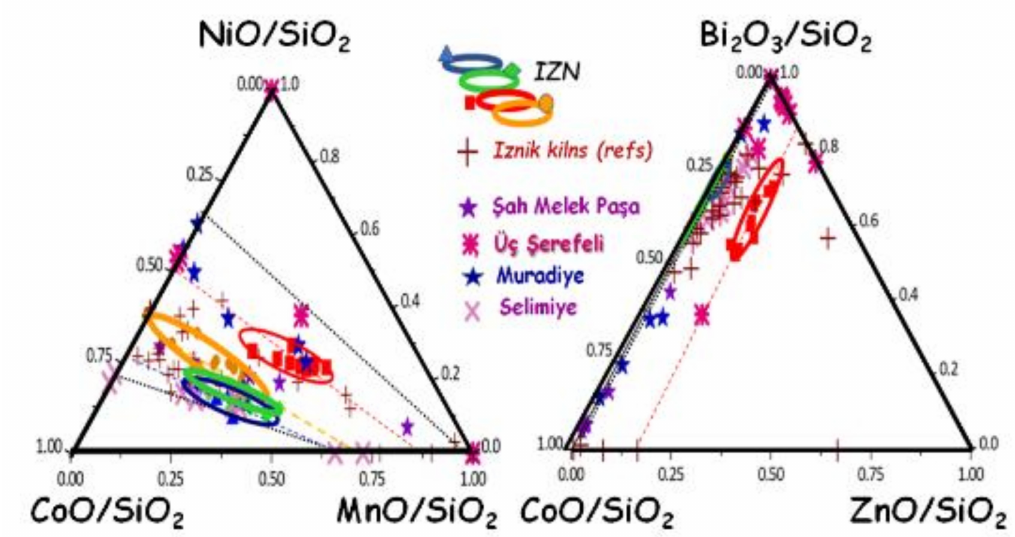
Figure 6. Comparison of the intrinsic variability measured on selected tiles with a set of measurements made on the blue areas of sherds previously excavated from Iznik tile kilns (see [22] for details) in comparison with measurements made on-site for tiles from Edirne mosques (¸Sah Melek Pa¸sa (1429), Üç ¸Serefeli (1410–1447), Muradiye (1435–1436), Selimiye (1569–1575)) (redrawn from Demirsar Arli et al. data